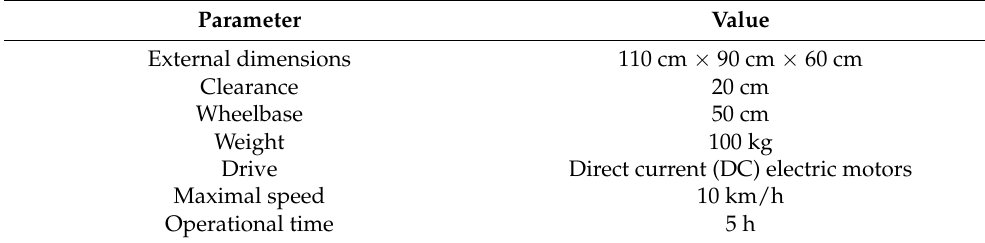
Table 1. Main UGV parameters.